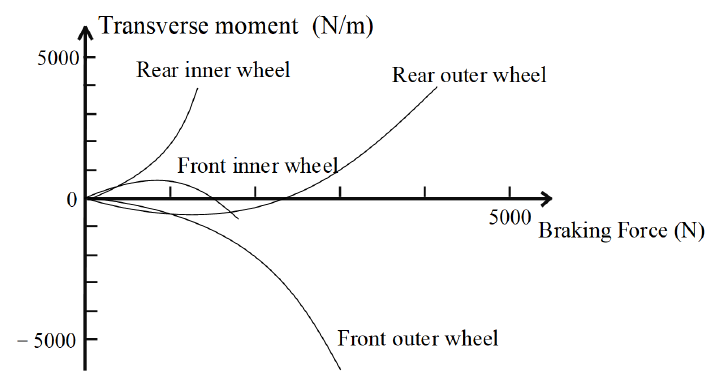
Figure 12. Relationship curve between wheel braking force and vehicle yaw moment.